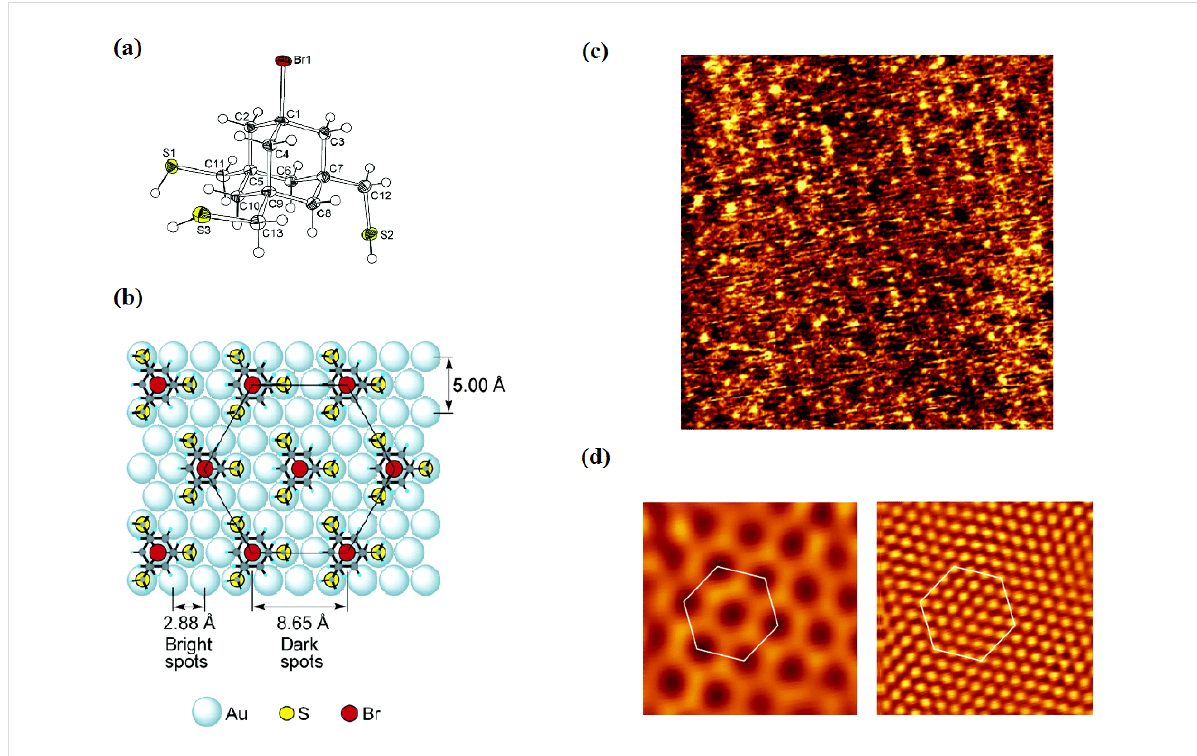
Figure 8: (a) ORTEP drawing of 17 as determined by single-crystal X-ray diffraction analysis at 100 K. Ellipsoids are drawn at the 50% probability level for non-hydrogen atoms. (b) Top view of a possible arrangement of 17 for the SAM on Au(111). The unit cell is shown by a hexagon. All mole- cules are drawn in the same orientation to minimize unfavorable intramolecular interactions. Sulfur atoms are assumed to be located on the near-top sites. (c) STM image of the SAM of 17 on a Au(111) surface, as measured in 0.1 M aqueous HClO 4 at ambient temperature. A silver wire was used as the reference electrode. Image area 12 nm × 12 nm, set point current 400 pA, bias voltage 700 mV, Au electrode potential − 300 mV, tip potential 400 mV. (d) Computer images of the 8.7 Å (left) and 2.9 Å (right) components of the lower left 4 nm × 4 nm area of (c). These images were obtained by inverse Fourier transform of each of the two intense frequency components obtained by two-dimensional Fourier transform of the raw image. The unit cell, indicated by hexagons, has a side length of 8.7 Å. Reprinted with permission from [85], copyright 2006 American Chemical Society.